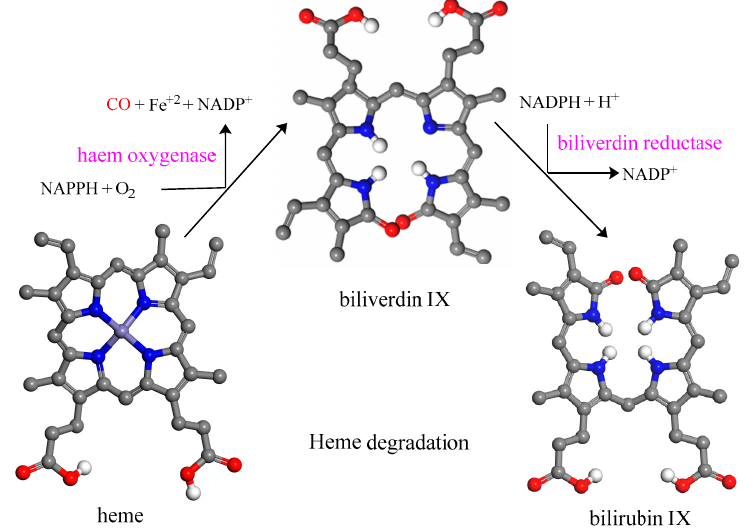
Figure 1. The intracellular carbon monoxide (CO) production by heme oxygenase (HO) in the mammalian system justifies its biological role.